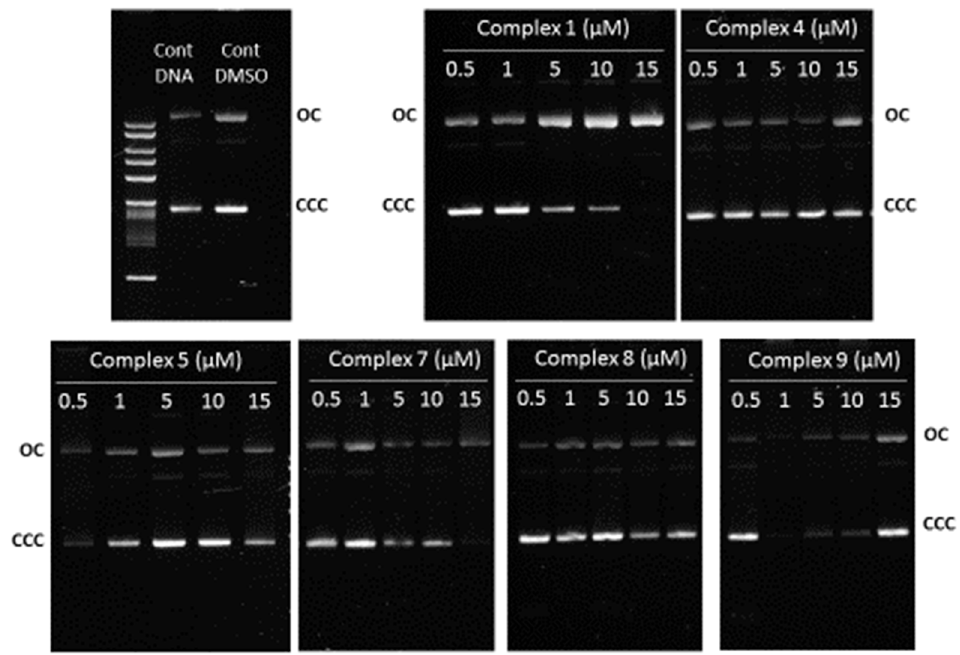
Figure 5. Assessment of the interaction of the complexes with DNA based on the evaluation of the samples’ electrophoretic mobility. Supercoiled φ X174 DNA was incubated with 0.5, 1, 5, 10, and 15 µ M of complexes 1 , 4 , 5 , 7 , 8 , and 9 for 24 h at 37 ◦ C, before samples were resolved using agarose gel electrophoresis. Open circular (OC) and covalently closed circular (CCC) forms of DNA are identified. The results for the respective ϕ X174 DNA controls incubated with and without DMSO are also shown.